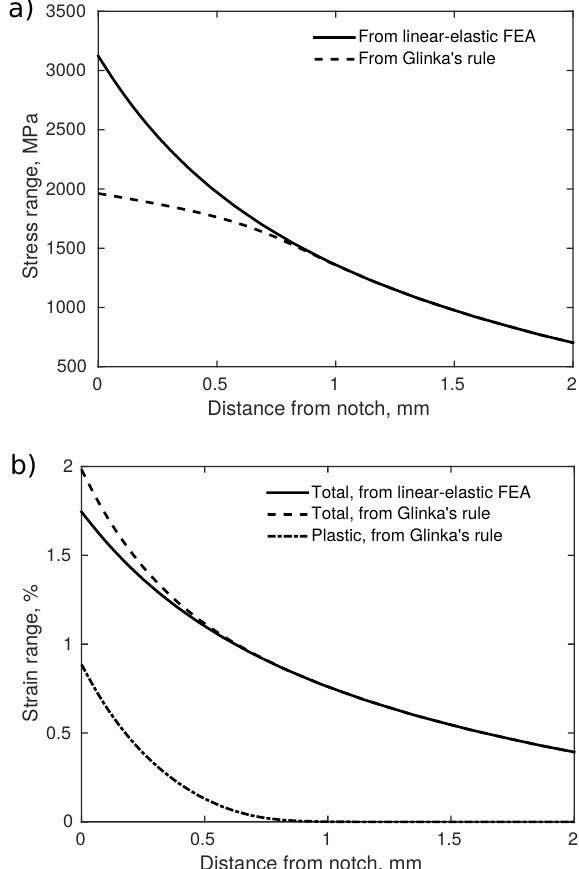
Figure 6. Stress and strain ranges from a linear- elastic finite element analysis (FEA) at 450 °C and 9.9 kN load subjected to a Glinka shakedown. a) Stress range as function of the distance from the notch. b) Total and plastic strain ranges as function of the distance from the notch. Figure from Ref.